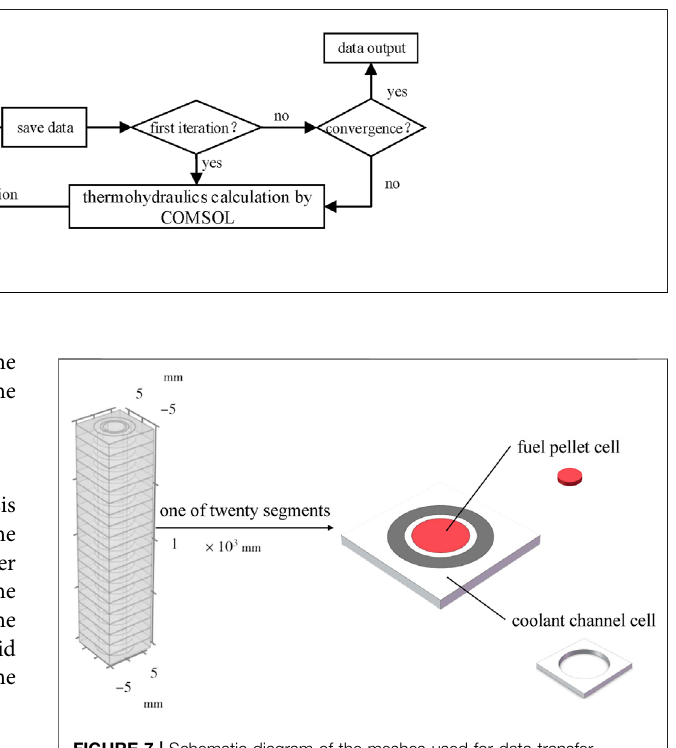
FIGURE 7 | Schematic diagram of the meshes used for data